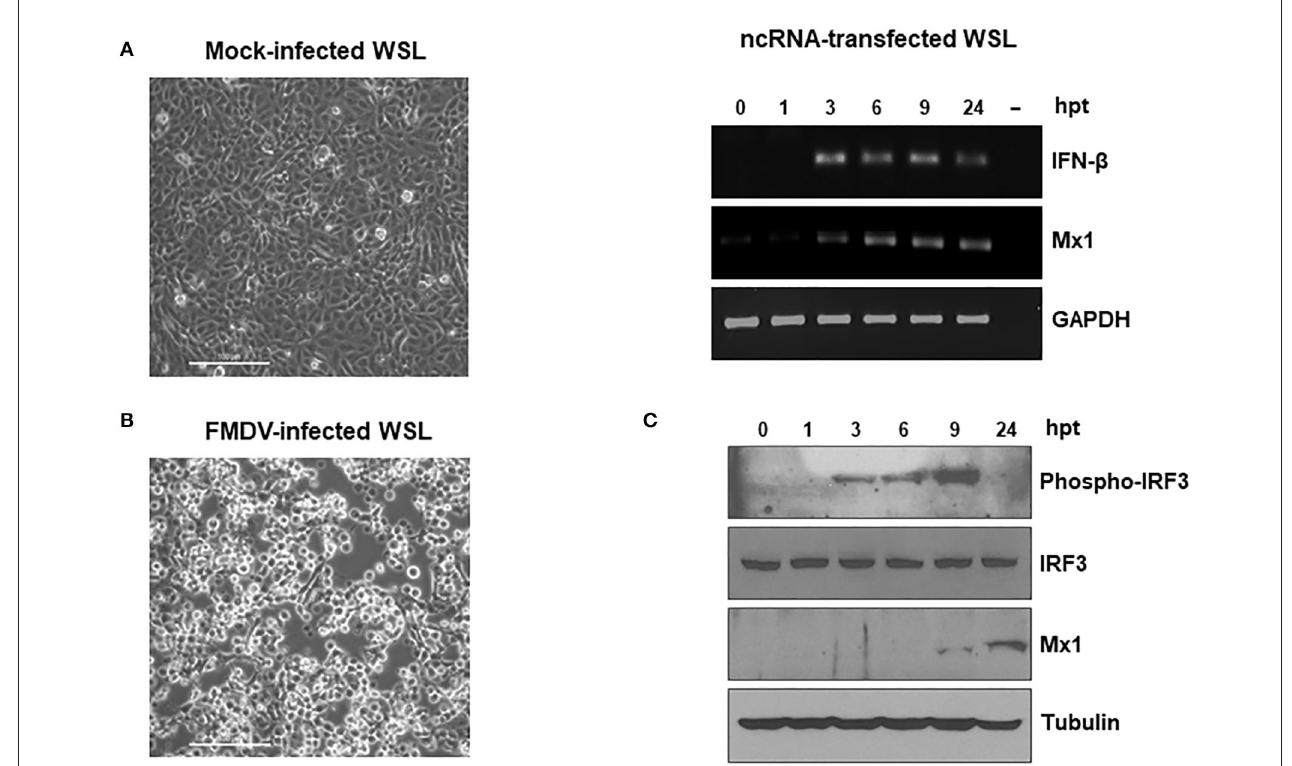
FIGURE 1 | WSL cells are susceptible to FMDV infection and induce innate immune responses upon transfection with the ncRNAs. (A) WSL cells were infected with FMDV O1BFS at an MOI of 0.01 or mock-infected. Images were captured 24h after infection. Scale bars, 100 µ m. (B,C) WSL cells were transfected with IRES RNA and cell lysates were collected at the indicated times after transfection for RT-PCR analysis of IFN- β , Mx1 and GAPDH mRNAs (B) or for protein detection of phospho-IRF3, total IRF3, Mx1, and tubulin by immunoblot (C) .